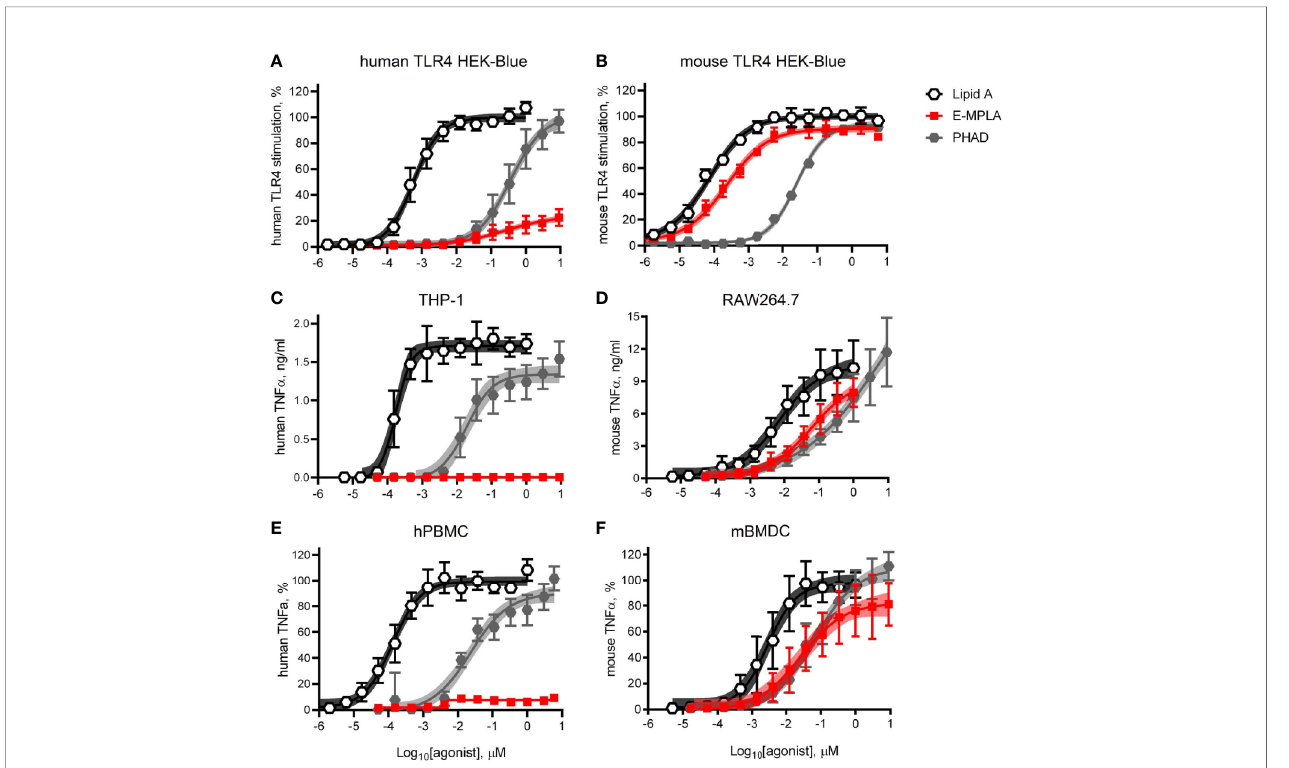
FIGURE 1 | Partial agonism of TLR4 by research-grade MPL adjuvant is species-speci fi c. HEK-Blue reporter cells, monocytic cell-lines, and primary cells of mouse and human origin were exposed to research-grade E-MPLA to compare dose response pro fi les. Dose curves were performed as half-log step dilutions from a peak concentration of 10 m M with exposure of cells for 18 – 24 h to synthetic E. coli chemotype Lipid A, its monophosphoryl counterpart PHAD, or MPLA from Enzo Life Sciences (E-MPLA). (A, B) show normalized responses of HEK-Blue reporter cells engineered to express human TLR4 or mouse TLR4 respectively; 100% = top dose plateau of the full agonist Lipid A. (C, D) show TNF a production by human monocytic THP-1 or mouse RAW264.7 cells, respectively. (E, F) show normalized TNF a production by human PBMC or mouse BMDC, respectively; 100% = top dose plateau of the full agonist Lipid A Average values ± SD combined from three (A, B, D, F) or two (C, E) independent experiments, each performed in triplicate, are shown along with shaded regions that indicate the 99% con fi dence intervals within which the true population means should occur 99% of the time. In each paired comparison research-grade MPLA-E scored as a partial agonist of human TLR4